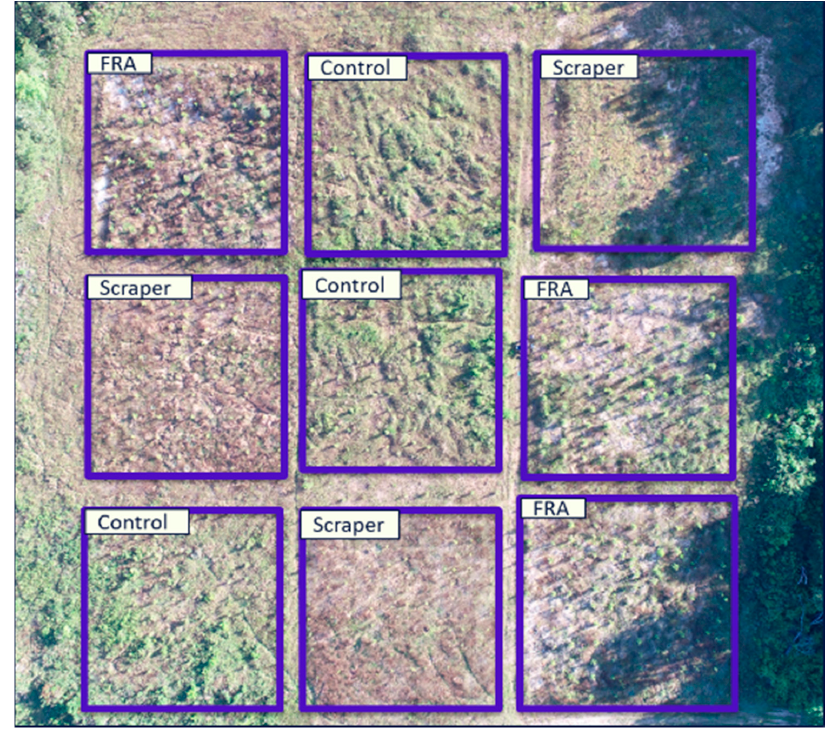
Figure 2. Oblique aerial imagery taken of the site in May 2018 depicting the RCBD design.